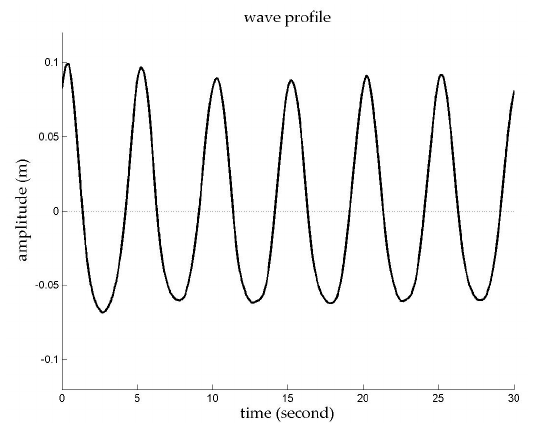
Figure 21. Experimental set-up in wave tank. The radar is fixed on the stationary blue carriage. The radar transceiver is the white square in the center of the red circle. It can rotate to transmit in different directions to adjust the angle to wave, 𝛽 .